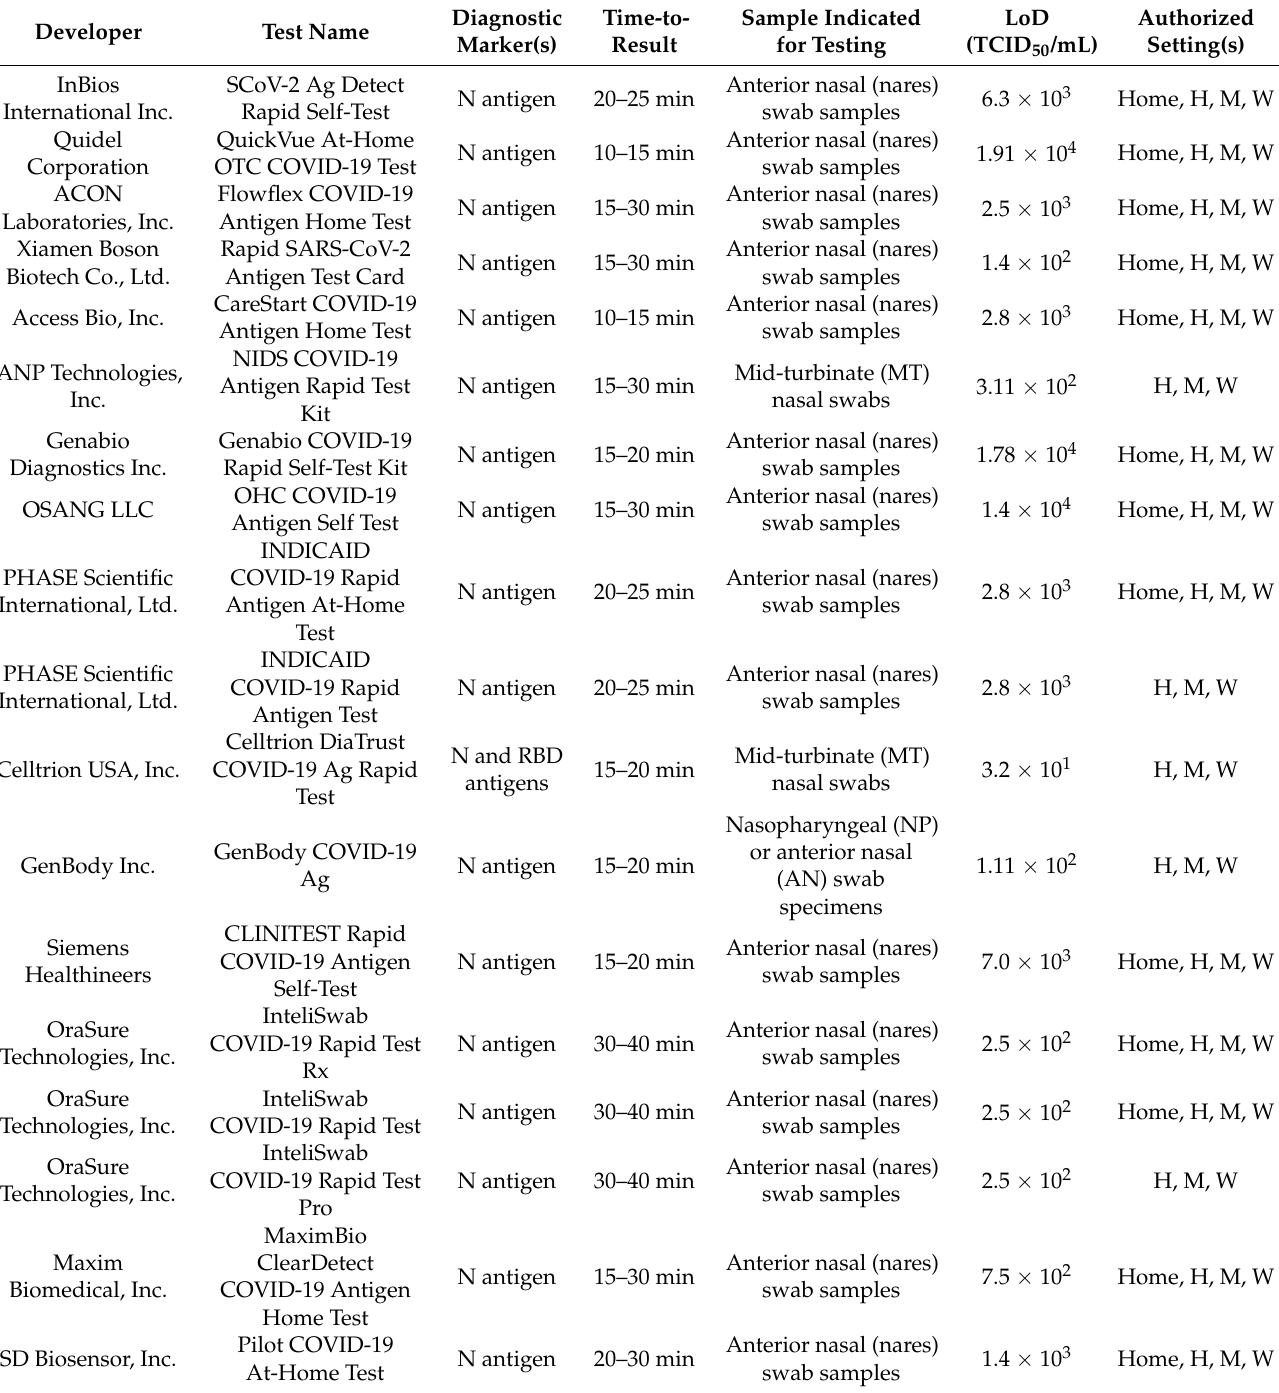
Table 2. Characteristics of FDA-EUA LFIs for the detection of SARS-CoV-2